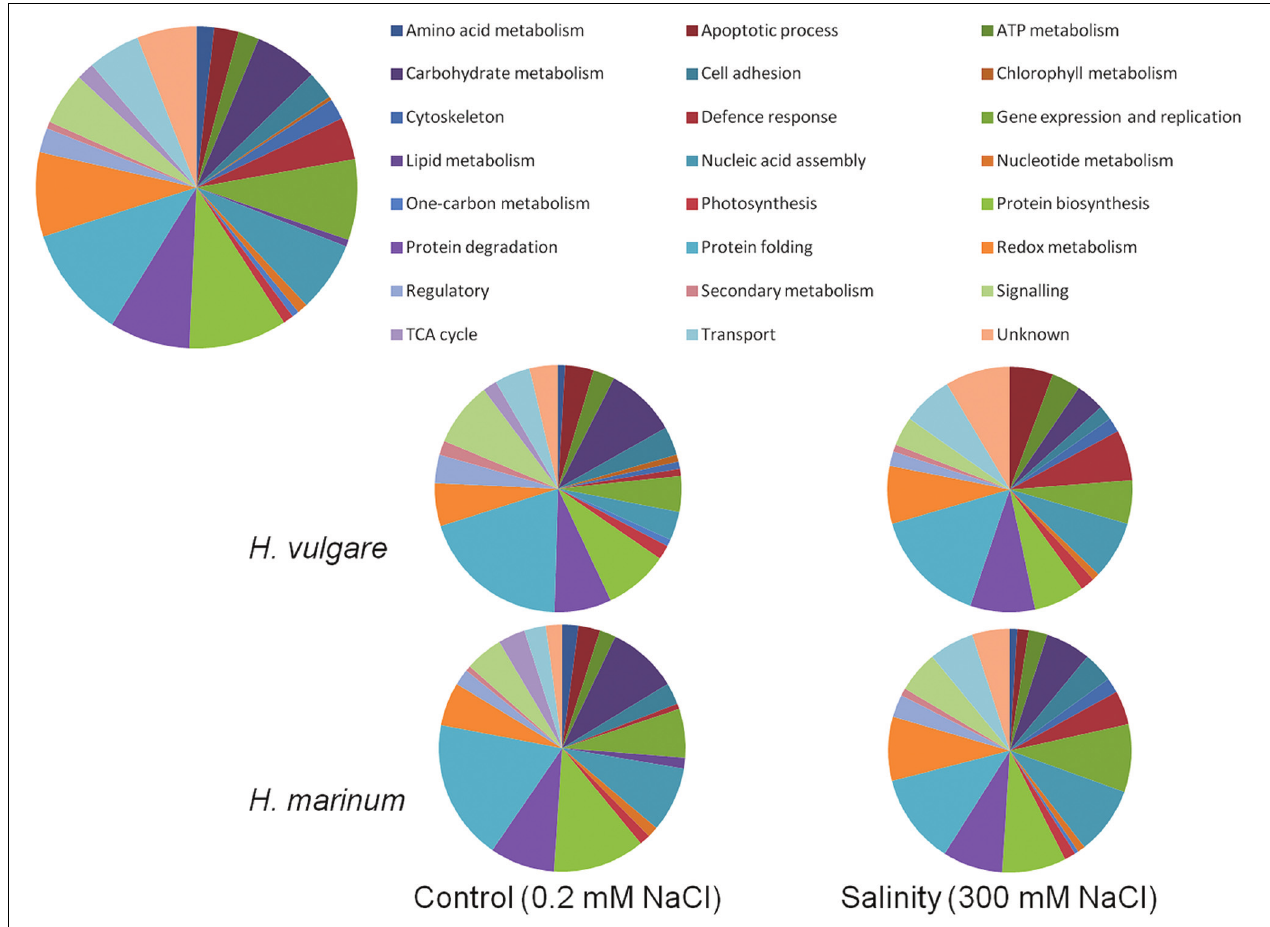
FIGURE 5 | Functional classification of identified proteins according to biological process. The upper diagram shows functional classification of all 284 identified proteins in the experiment while the four lower diagrams show functional classification of the identified proteins in the individual experimental variants.